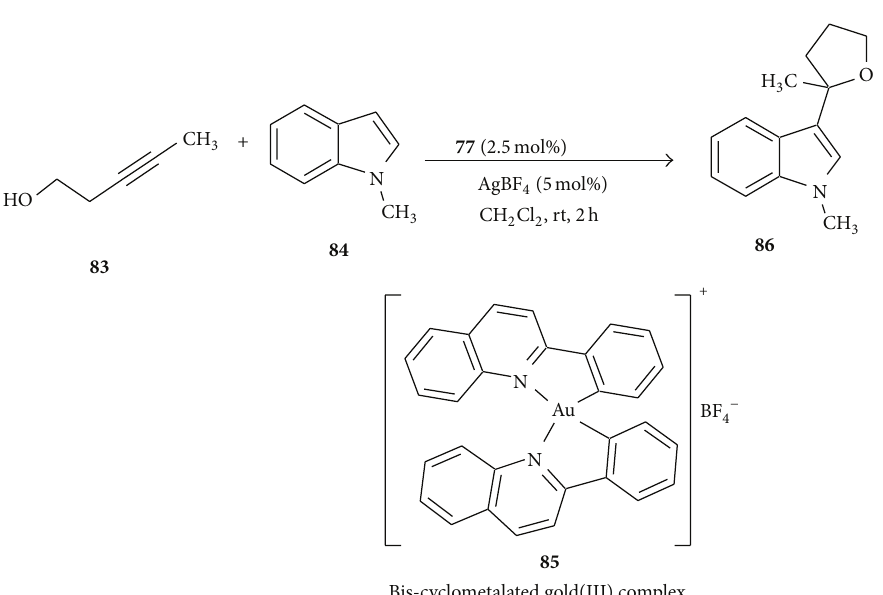
Scheme 15: Synthesis of (-)-erythramine 82 .